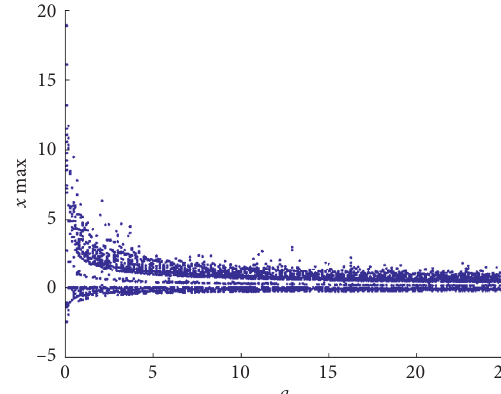
Figure 9: Bifurcation diagram versus the parameter c at order κ � 0 .